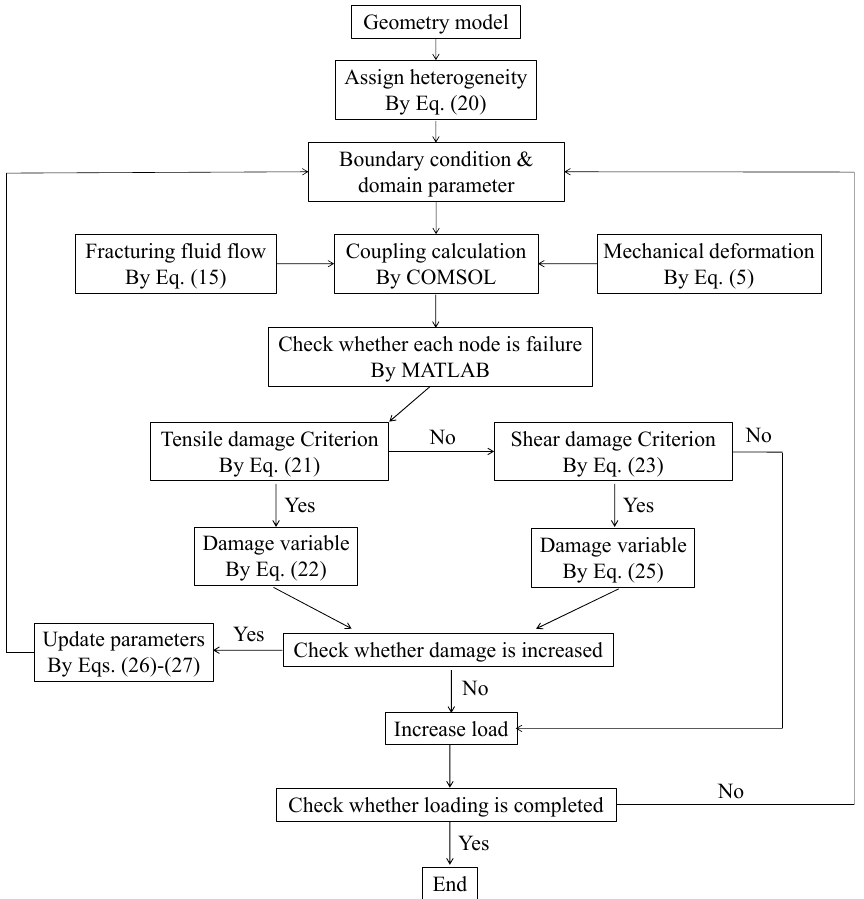
Figure 6. Computational schematic chart in the numerical simulation.